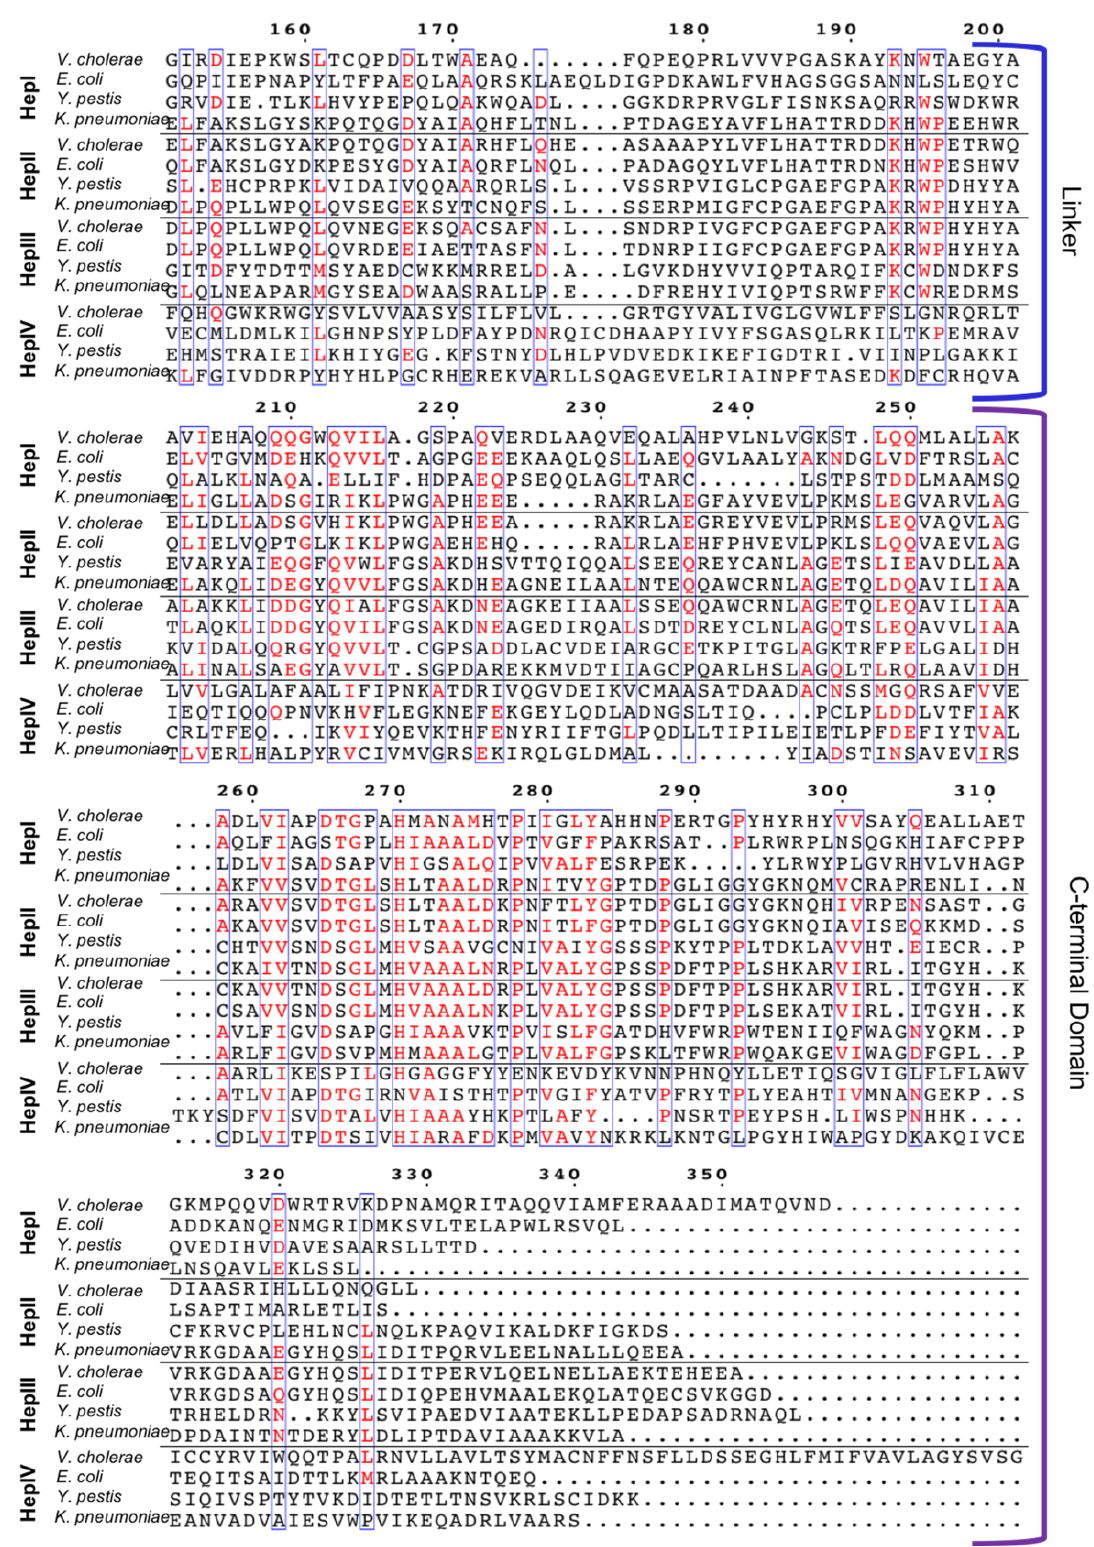
Figure 5. Muliple sequence alignment of HepI–HepIV from Vibrio cholerae , Escherichia coli , Yersinia pestis , and Klebsiella pneumoniae (domains for HepI E. coli HepI are annotated), using ClustalW 2.0 (https://www.ebi.ac.uk/Tools/msa/clustalw2/) alignment program and Espript 3.0 (ESPript—http://espript.ibcp.fr)